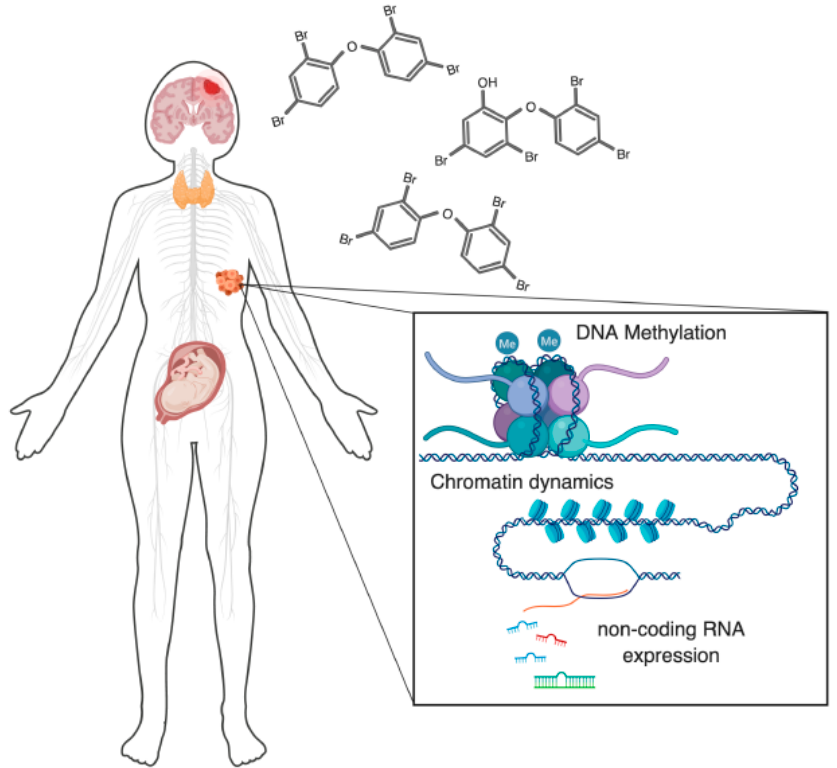
Figure 1. Polybrominated diphenyl ethers (PBDE) exposures affect epigenetic regulatory mechanisms at multiple levels, across multiple biological systems. There are several major aspects of human